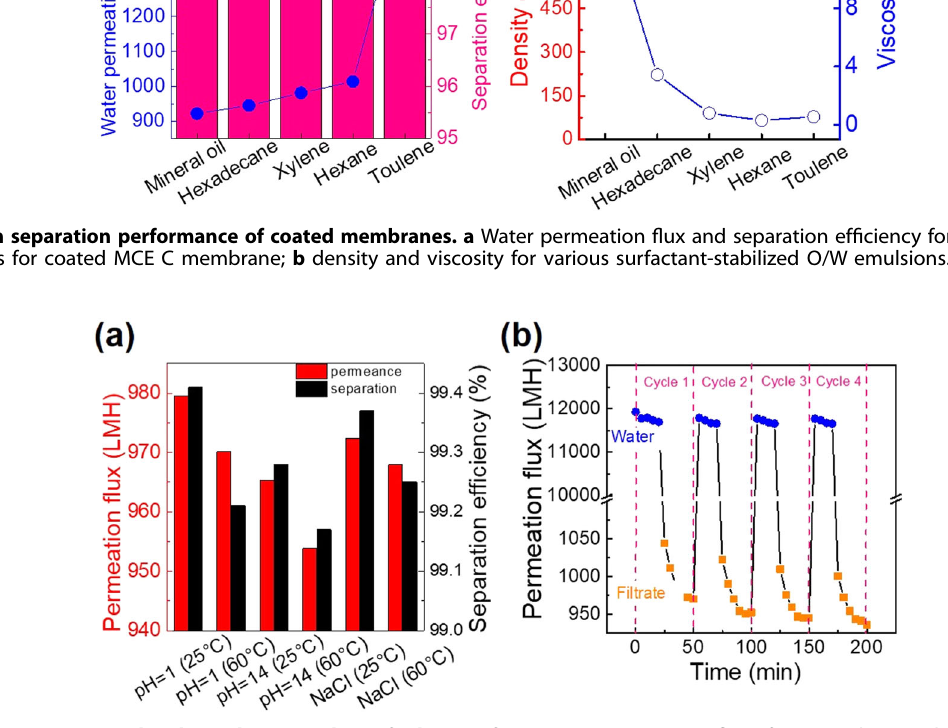
Fig. 7 Emulsion separation in harsh conditions and anti-fouling performance. a Permeation fl ux of MCE C when applied to the emulsion of hexadecane in water under harsh environments (pH = 1, pH = 14, and 3% NaCl); b separation performance and fl ux recovery of coated MCE C